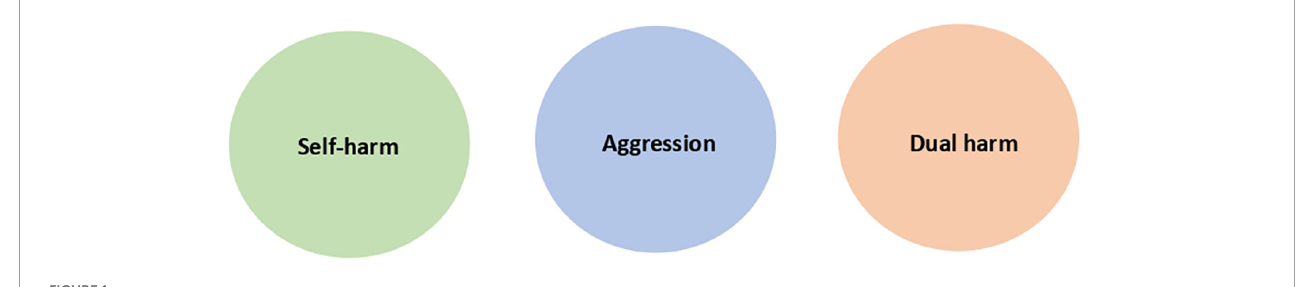
FIGURE1 Dual harm as a unique behavioural construct.